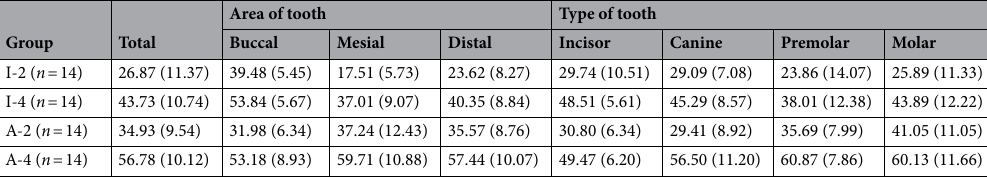
Table 1. The means (in percent) and standard deviation (SD) of the cleaned areas of each cleaning group (I-Prox P brush for 2 s (I-2) and four seconds (I-4) and the Airflow for 2 sprays (A-2) and four sprays (A-4)).